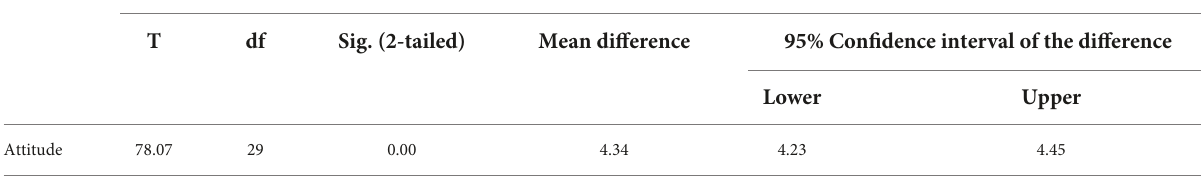
TABLE 7 One-Sample t -test results for the experimental participants’ attitudes